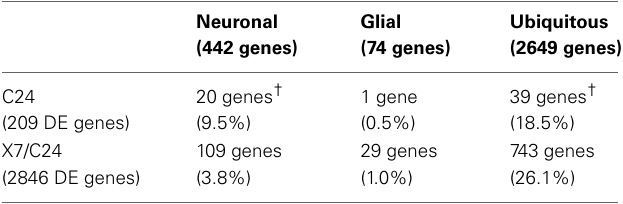
FIGURE 6 | Comparative analysis of global and Smn expression profiles in Smn X7 /elavGAL4-C24 (X7/C24) and elavGAL4 (WT) flies. (A) Spatial distribution of global expression trends in WT and X7/C24. PCA was applied to the stabilized variances estimated from normalized reads counts of Table 2 | Differentially expressed genes in C24 or X7/C24 flies that are classified as having neuronal, glial or ubiquitous expression in Flybase.